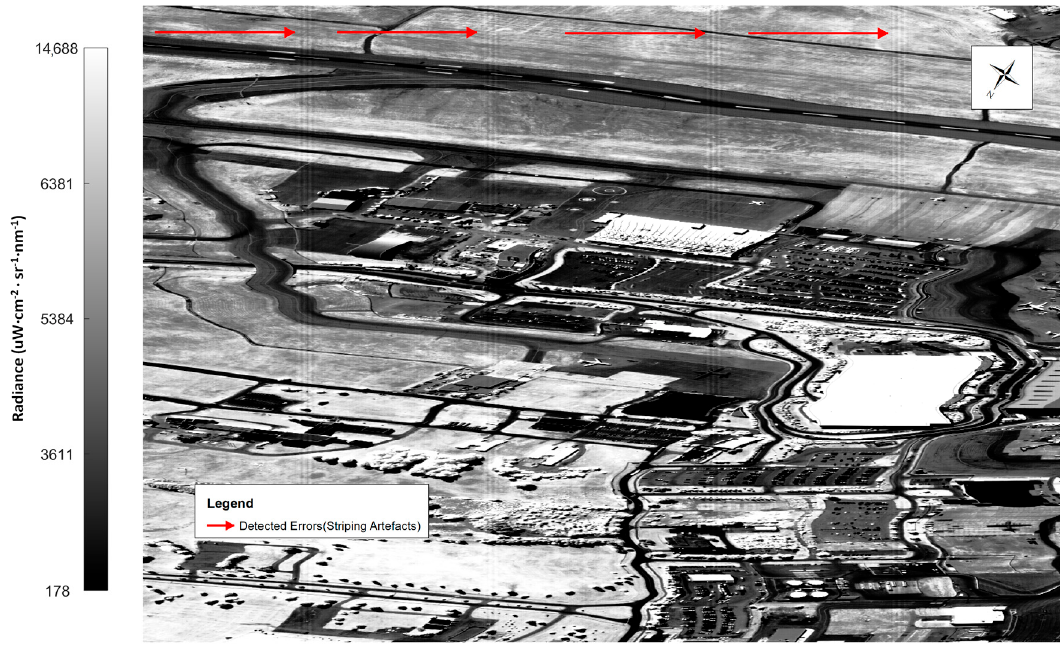
Figure 21. Histogram-equalized CASI imagery (24 June with original processing) at 835.491 nm. The red lines show the locations of distinct “striping” artefacts.